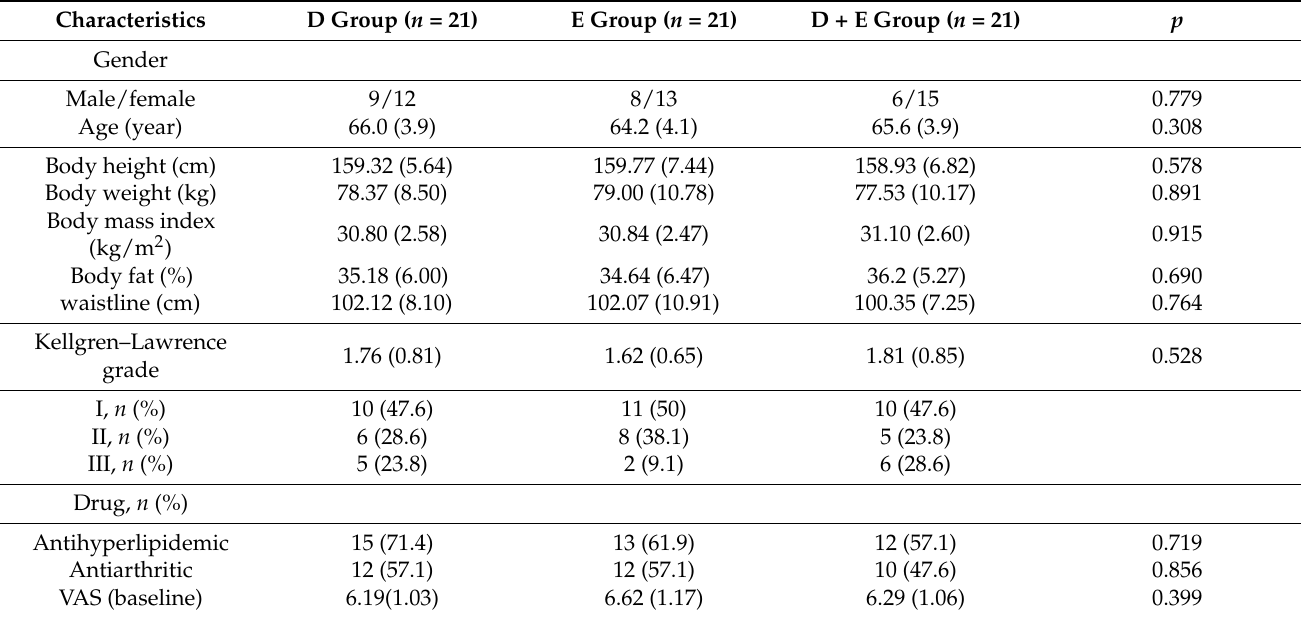
Table 1. Baseline characteristics of